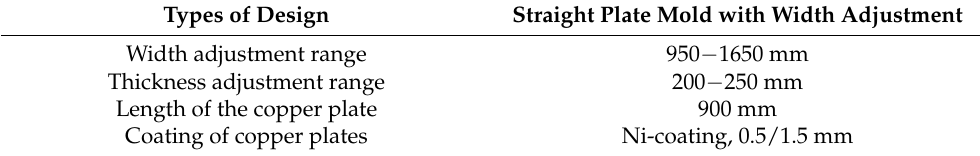
Table 2. Technical data of